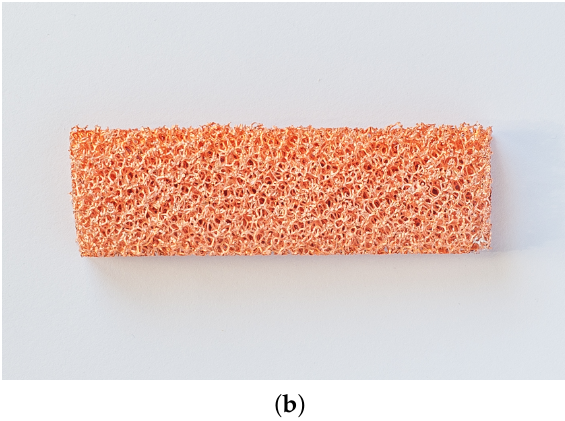
Figure 1. Samples of aluminium ( a ) and copper ( b )